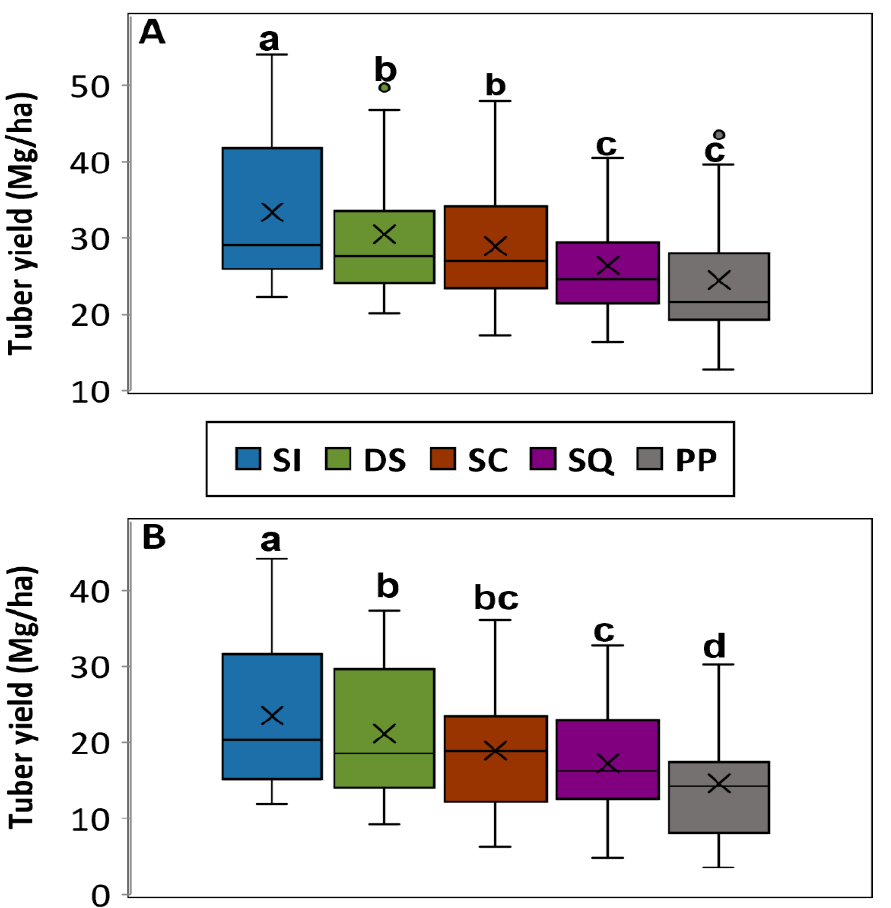
Figure 2. Effects of cropping system (SQ—standard rotation, SC—soil conserving, SI—soil improving, DS—disease suppressive, and PP—nonrotation control) on ( A ) total and ( B ) marketable tuber yield over a 4-year period (2015–2018). Bars topped by the same letter are not significantly different from each other based on pairwise t -tests ( p < 0.05). Data points outside of the depicted range indicate outliers.